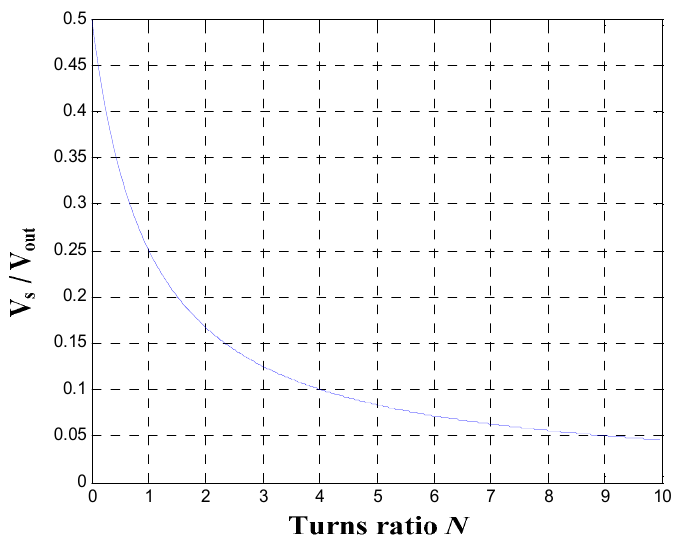
Figure 6. Relation curve between turns ratio and normalized switch voltage stress ratio.